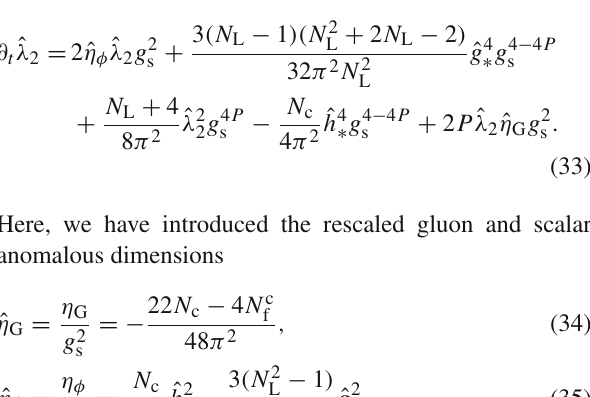
Fig. 2 The upper critical surface h 2 = (cid:15)( g 2 s , g 2 ) of total AF for the perturbatively renormalizable model in the DER and for the SM set of parameters summarized in Eq. (10). The special trajectory in Eq. (30) along which h 2 is proportional to g 2 as well as g 2 s is highlighted by a red line. It is a UV attractive (repulsive) trajectory along the directions tangent (orthogonal) to the critical surface. The intersection of (cid:15) with the g 2 = 0 plane is highlighted by a green line with a slope given by Eq. (18); the intersection of (cid:15) with the g 2 s = 0 plane is shown as a purple line satisfying h 2 = g 2 s = 0. The arrows of the RG stream flow on the top of the critical surface are pointing towards the